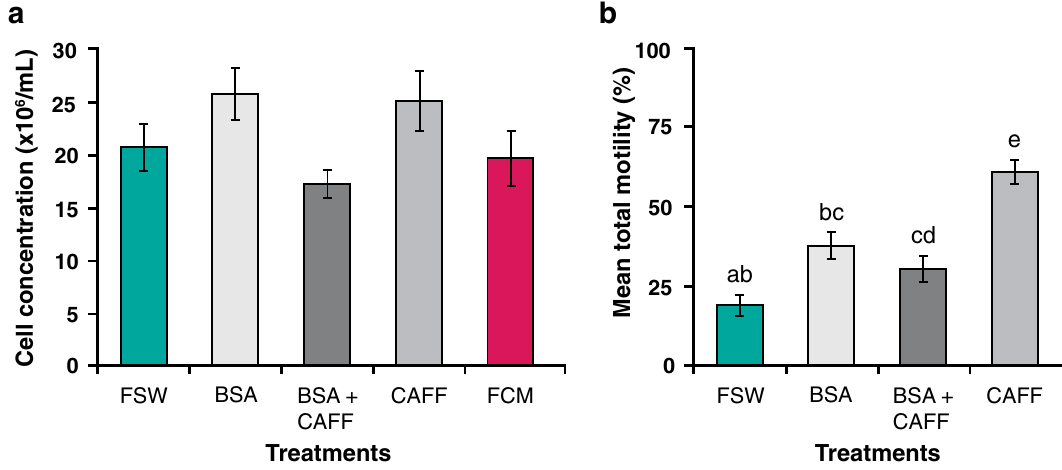
Figure 2. Lobactis scutaria sperm samples (n = 14) were treated with four different solutions for 5 min, and the total concentration and corresponding sperm motility were measured on a CASA. A flow cytometer was used to ground-truth the fresh total concentration of the sperm samples. ( a ) The total concentration of the L. scutaria sperm was measured by CASA under four different conditions, using FSW (filtered seawater); BSA (Bovine Serum Albumin); BSA-CAFF (Bovine Serum Albumin and Caffeine); and CAFF (Caffeine). No difference was observed amongst the means (ANOVA; P = 0.08, F = 2.22), suggesting that the treatments had no effect on the measured mean total concentrations. ( b ) The resulting mean total sperm motilities were different based on treatments; CAFF was the highest with almost double the mean motility (ANOVA; P < 0.001, F = 18.1). The small letters indicate treatments that are different. Error bars are SE.